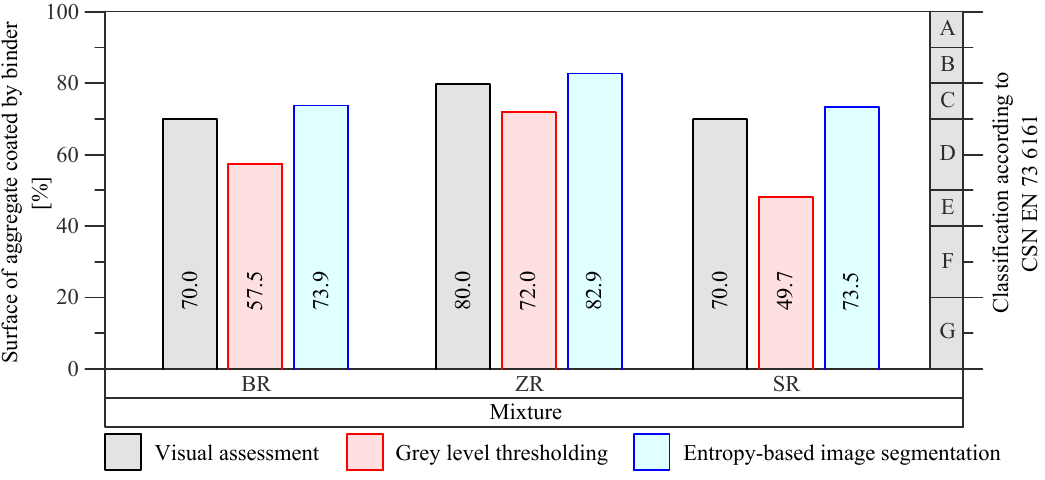
Figure 2. Assessment of adhesion between reference bituminous binder and three types of aggregates.